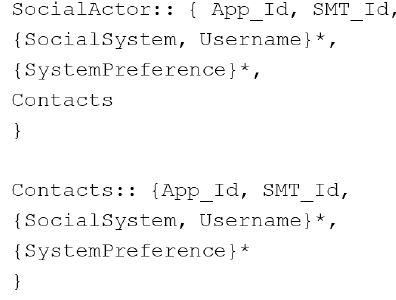
Figure 3. Conceptual structure of a Social Actor.